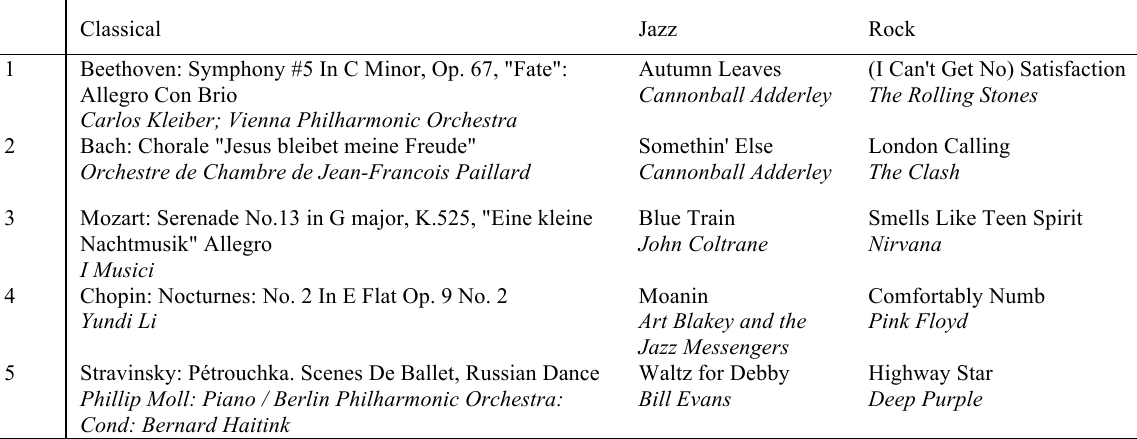
Table 1 Excerpts used in the current study. Artists are indicated with